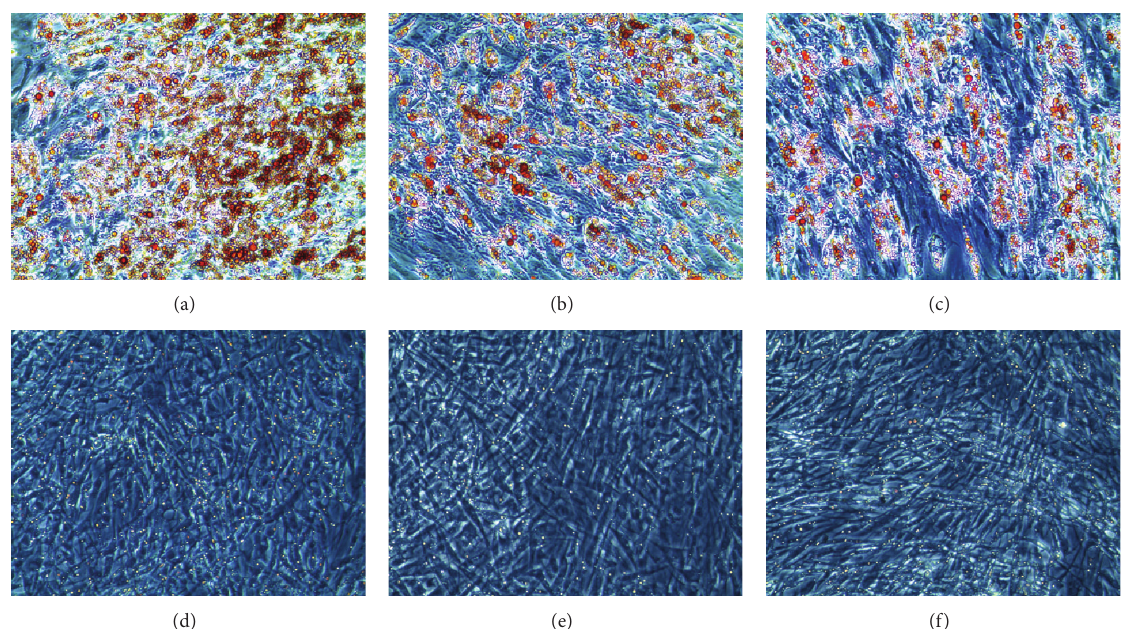
Figure 2: Representative Oil Red O staining of adipogenically differentiated ADSC ((a), (b), and (c)) and not induced control ADSC ((d), (e), and (f)) of three donors demonstrating accumulation of intracellular fat droplets as a sign of adipogenic differentiation in (a), (b), and (c).